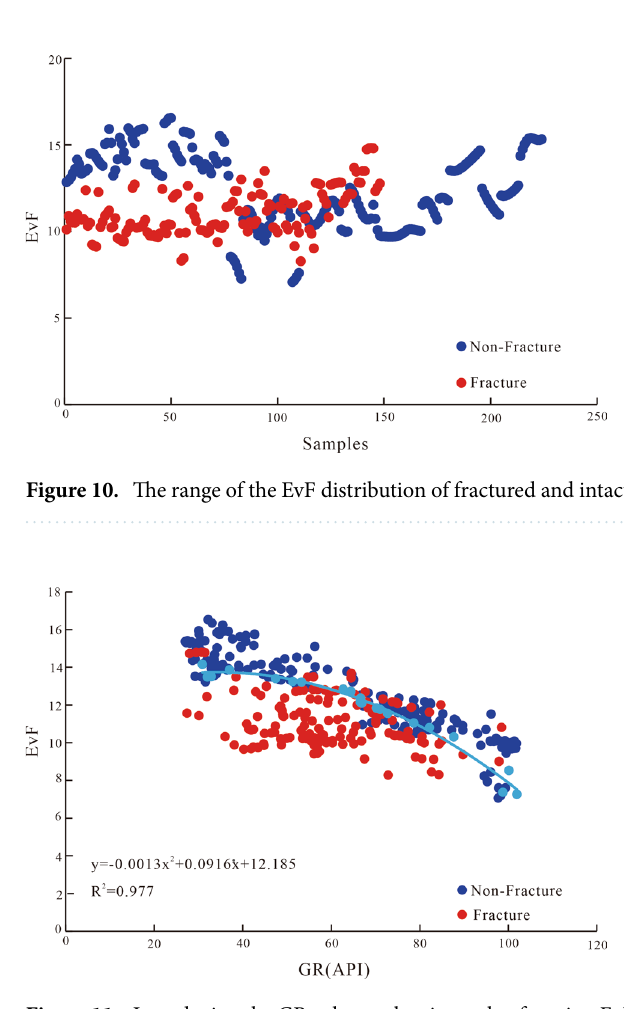
Figure 11. Introducing the GR value to the eigenvalue function EvF further enhances distinguishing fractured and intact rock